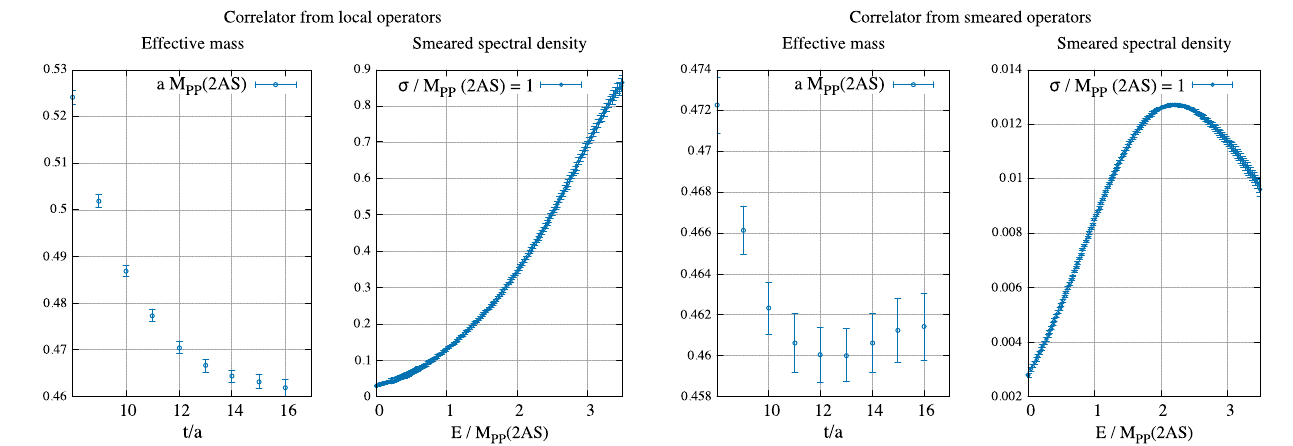
Fig. 9 Results from Fig. 8, this time using Gaussian-smeared inter- polators according to Appendix C. These operators are tuned to have smaller overlaps with the excited states. Consequently, the effective mass plot on the left reaches a plateau, providing an estimate for . Therightpanelsimilarlyshowshowsuppressedexcitedstates aM ( 2AS ) PP allow for a clear peak to emerge in the spectral reconstruction smeared ( 2AS ) with σ = M accordingtoEq.(48).Thepeakincludescontributions PP from mainly M Π and E